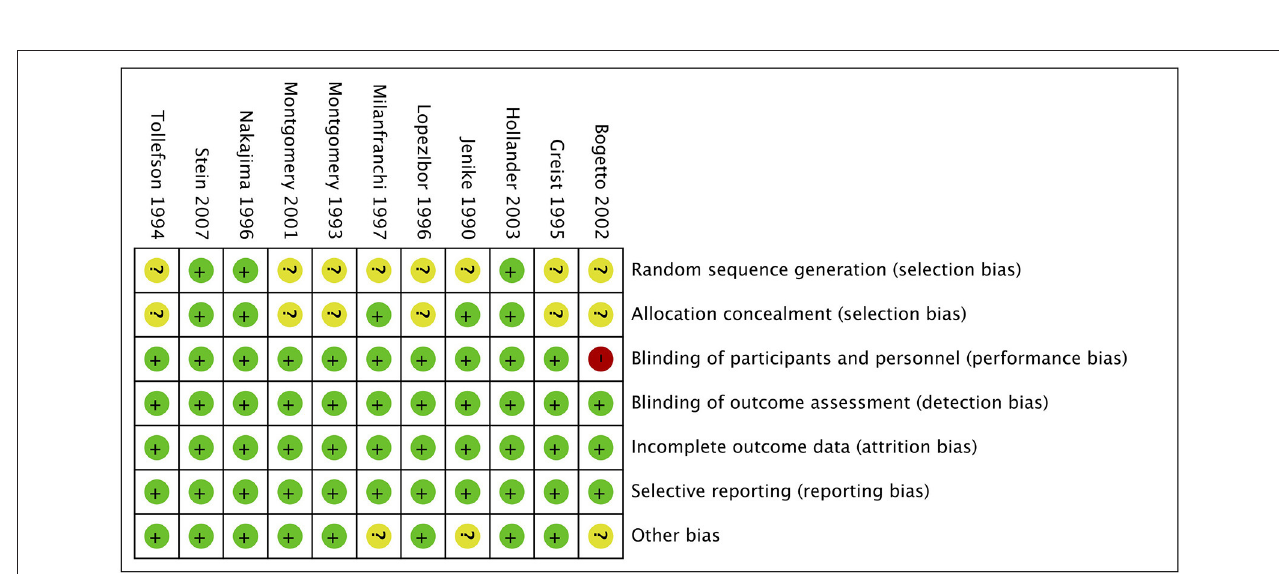
FIGURE 2 | Summary of risk bias in clinical controlled trials of SRIs in OCD adults. Green circles, low risk of bias; yellow circles, unclear risk of bias; red circles, high risk of